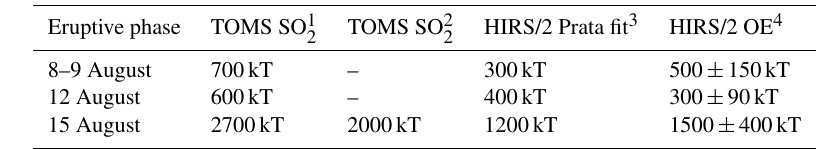
Table 3. Total erupted SO 2 rounded estimates for Cerro